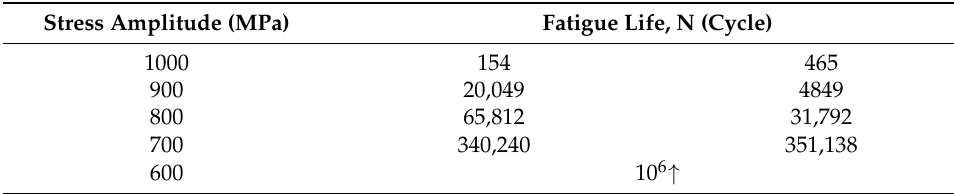
Table 7. The fatigue test result of SKD61 at 500 ◦ C.